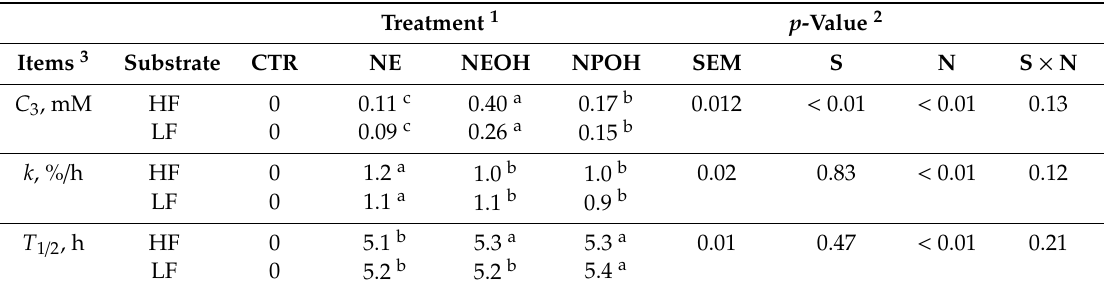
Table 4. The disappearance kinetics of nitrite (NO 2 − ) during in vitro ruminal fermentation of substrates